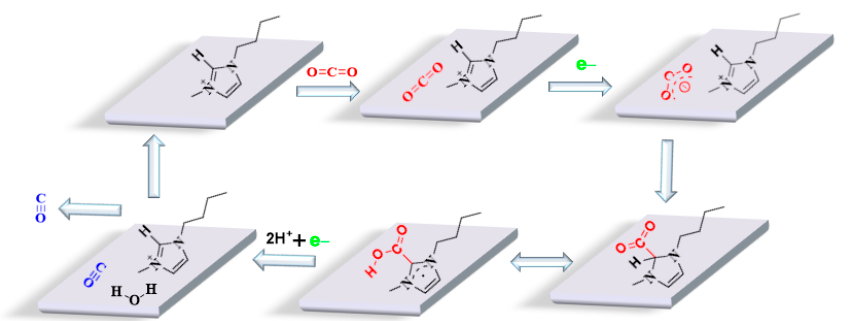
Figure 7. Schematic diagram of electroreduction of CO 2 in [Bmim]BF 4 /PC solution with Ag as working electrode.